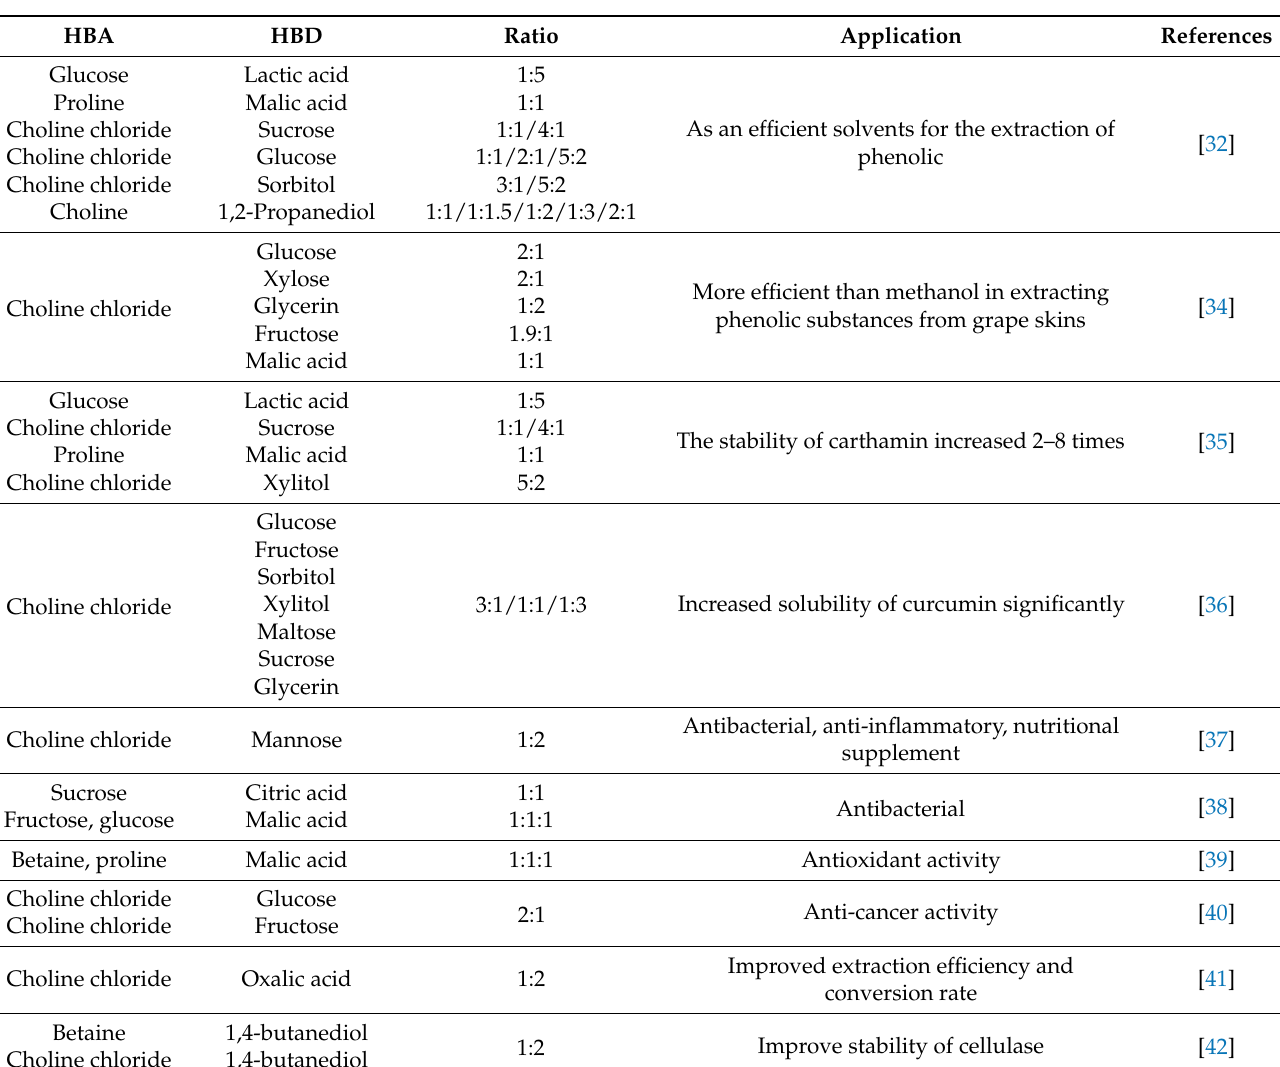
Table 1. The composition and application of some